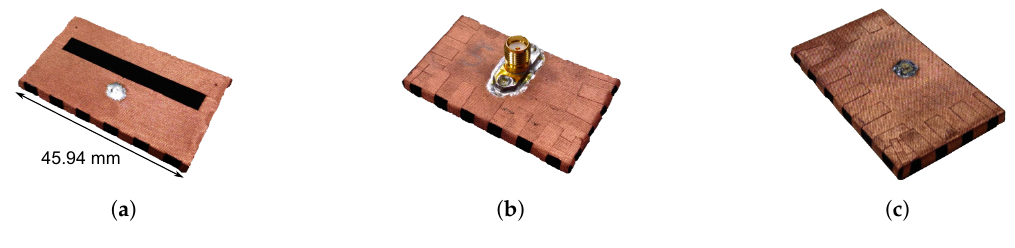
Figure 6. Final design. ( a ) Final design: slot plane; ( b ) Final design: back plane with SMA connector; ( c ) Final design: back plane with U.FL